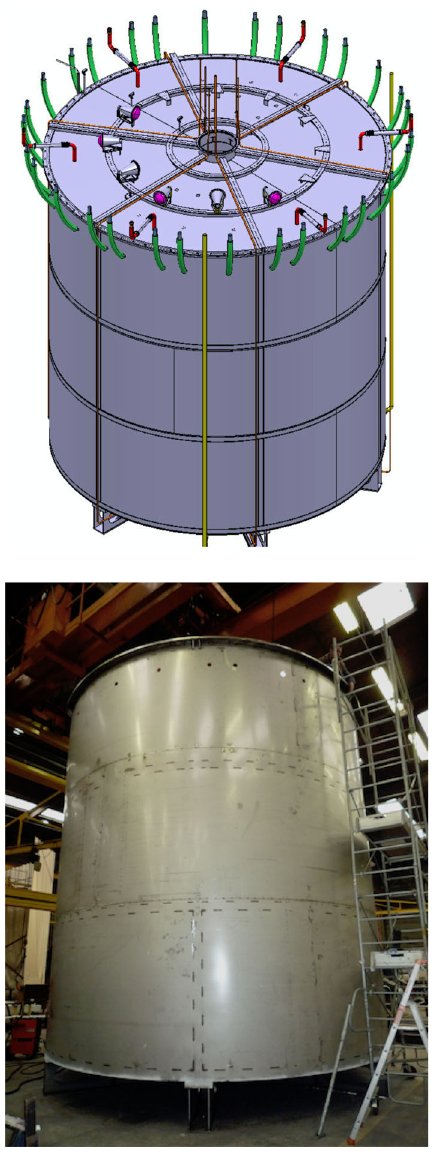
Fig. 3 Technicaldrawing(top)andphotograph(bottom)oftheDouble Chooz Buffer vessel, composed of a frame made of stiffening profiles (1565 kg) on which a “skin” made of 3 mm thick steel sheets (4500 kg) was fixed. It rested on 6 feet (3525 kg) and supported the 390 photomultiplier tubes, drain and expansion